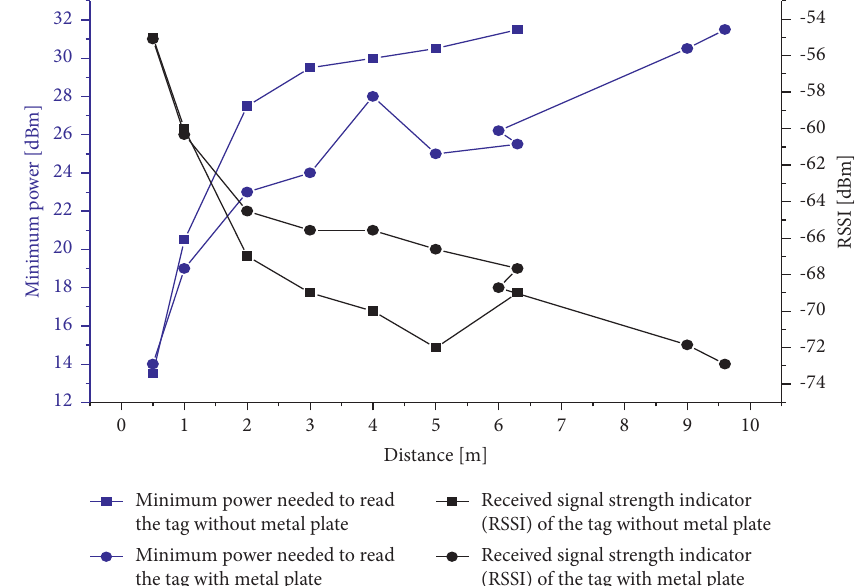
Figure 11: Read range and RSSI which are measured when the tag antenna is placed in the free space and on the metal plate (30cm × 30cm) in the direction of φ � 90 ° in the xy -plane.